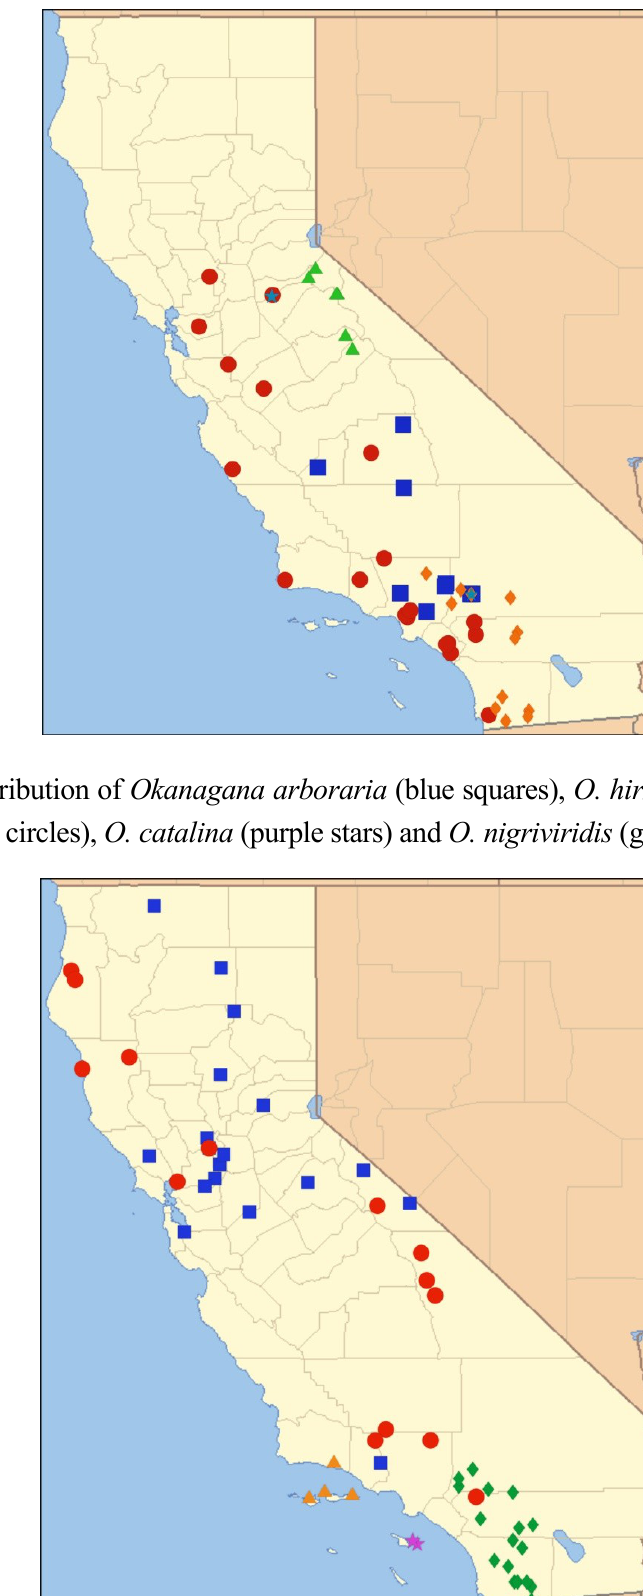
Figure 62. Distribution of Okanagana arctostaphylae (light blue stars), O. opacipennis (orange diamonds), O. uncinata (red circles), O. venusta (dark blue squares) and O. villosa (green triangles).